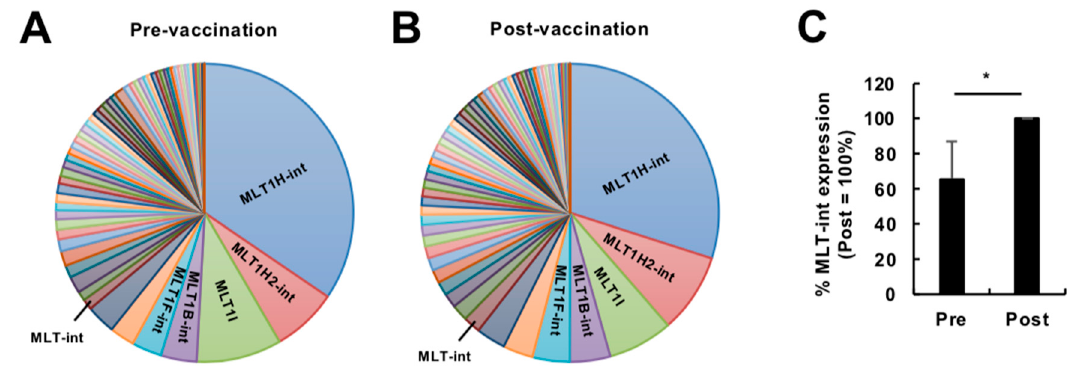
Figure 2. Expression profiling of transcripts containing retroelements in the human blood during vaccination at a low dose. ( A , B ) Diversity of transcripts containing the MaLR elements expressed in peripheral blood cells before ( A ) and at 24 h after ( B ) vaccination at a low dose (GSE98212, low-dose, N = 5). The vaccination was administered to humans in a previous study using a replication-defective simian adenovirus expressing two Leishmania proteins at a low dose (for more details, see Reference [6]). The top five elements and MLT-int are indicated. ( C ) Expression of MLT-int-containing transcripts before (Pre) and after (Post) vaccination. The percentage of MLT-int expression (RPKM) before vaccination to that after vaccination for each subject was calculated. The values are expressed as the mean ± SD; * p < 0.05.